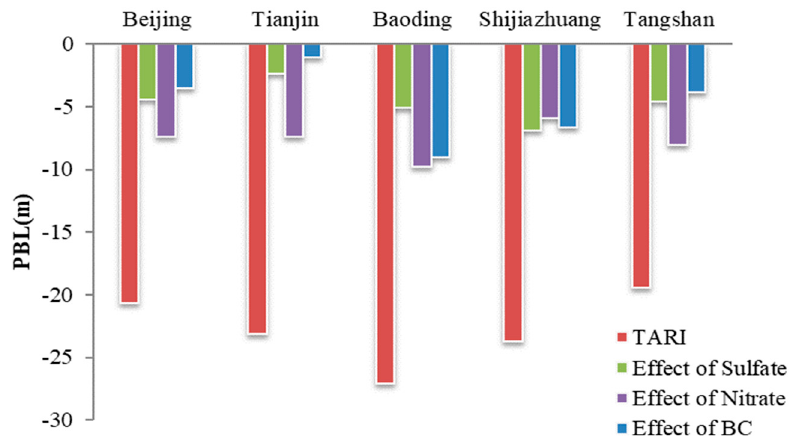
Figure 9. Simulated results of the ARI effects on the planetary boundary layer (PBL).